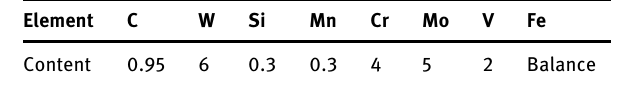
Table 1: Chemical compositions of the W 6 Mo 5 Cr 4 V 2 substrate ( wt% )